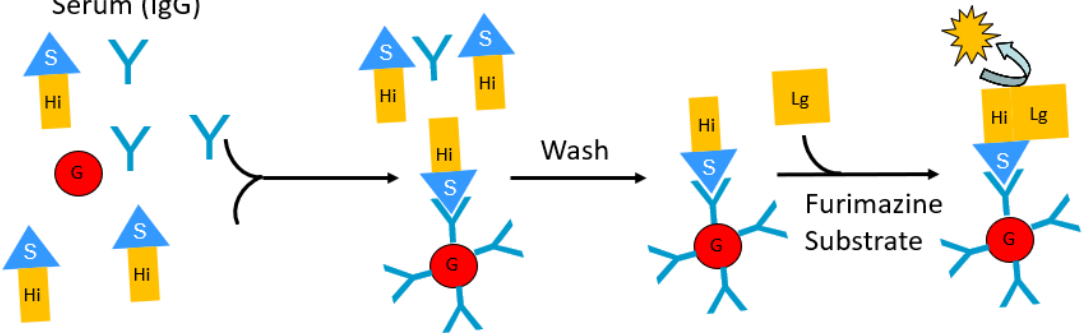
Figure 3. A LIPS-like split luciferase immunoassay for antibody measurements. This immunoassay format utilizes split luciferase fragments in a LIPS-like assay. As shown above, for detecting antibodies to the receptor binding domain (RBD) of SARS-CoV-2 spike protein (S), a fusion protein encoding the cDNA for RBD of the spike protein is genetically fused with the HiBiT split luciferase Nano fragment. This recombinant spike RBD-HiBiT fusion protein is incubated with patient serum samples in the presence of protein G IgG-binding beads. After washing, the non-bead-bound spike RBD-HiBiT protein is removed. Next, the LgBiT along with furimazine substrate is added. If the HiBit-SARS- CoV2 spike protein is present, the self-assembling LgBiT protein fragment binds and reconstitutes a functional Nano enzyme producing light that is measured by a luminometer. The amount of specific RBD spike antibody is proportional to the amount of bound antigen